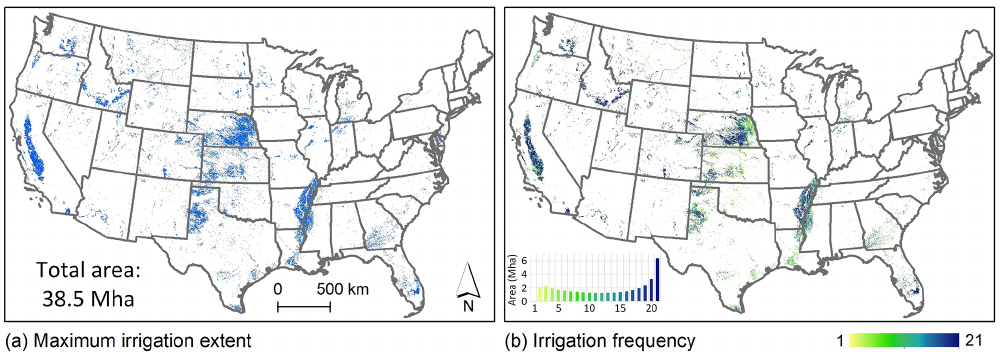
Figure 9. The maximum irrigation extent (lands that have been irrigated at least once) and irrigation frequency (the number of irrigated years) across the CONUS for the period 1997–2017. The inset in (b) shows the area of each frequency